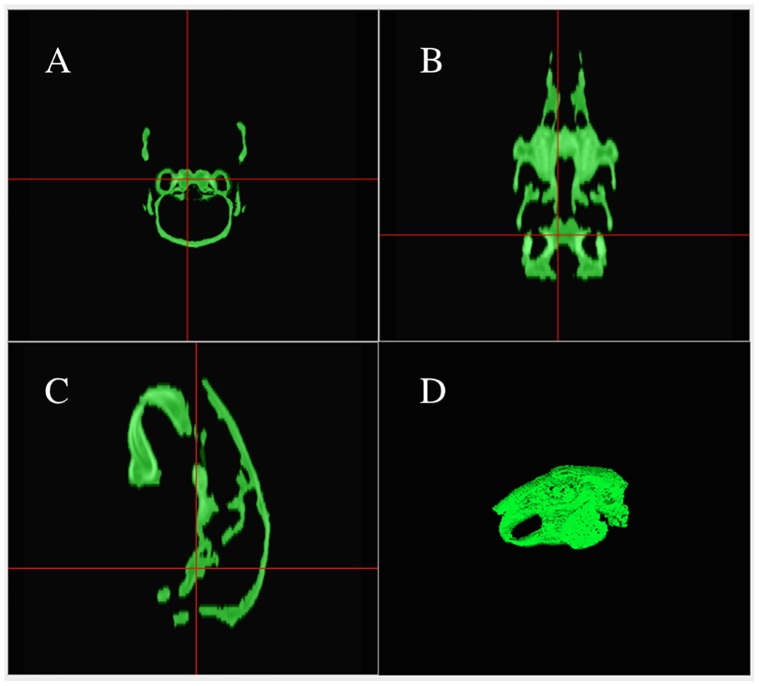
Final window showing the segmented bone and summary of 3D volume parameters: Volume (mL), Mean HU, STD HU, Max HU and Min HU.A-C are the multiplanar reconstruction sample images and the final 3D volume region of interest (D).